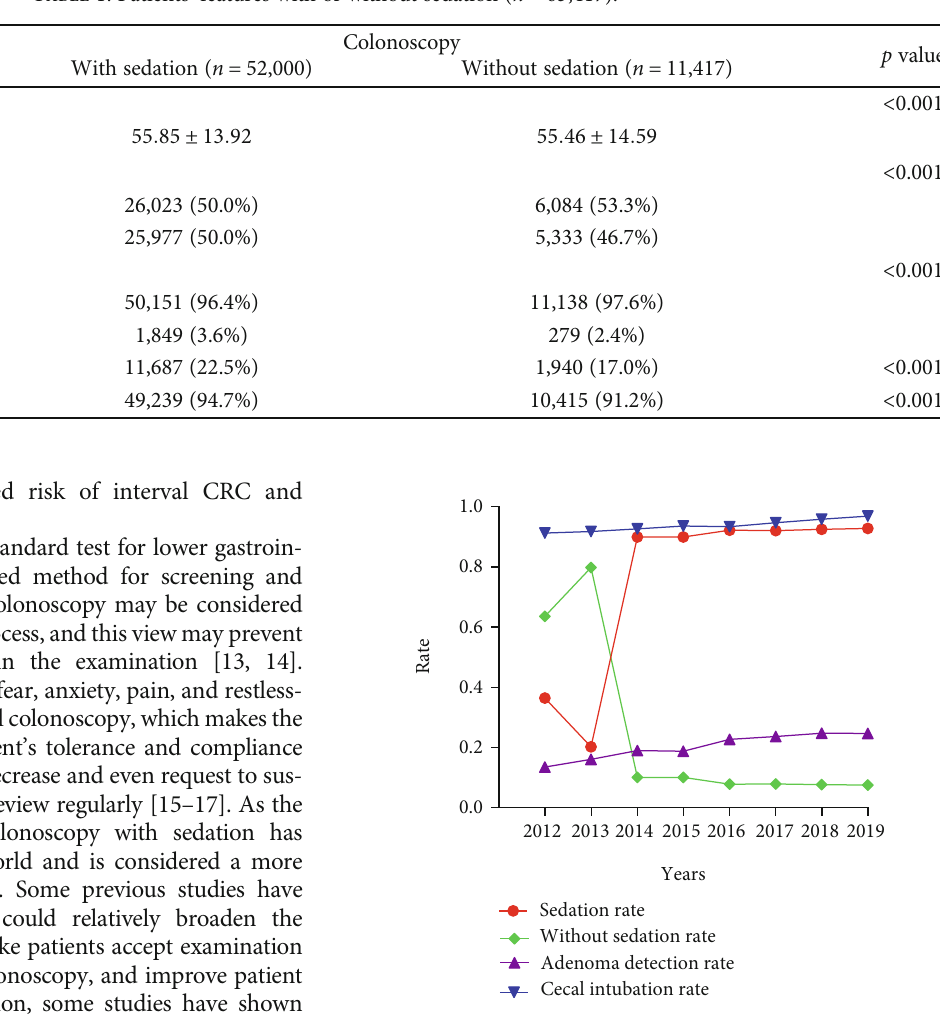
Table 1: Patients ’ features with or without sedation ( n = 63,417 ).